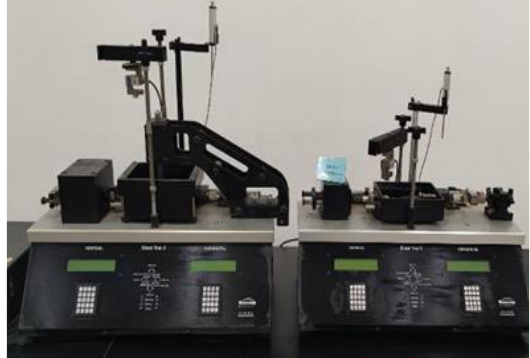
Figure 7. Shear Trac-II test system.